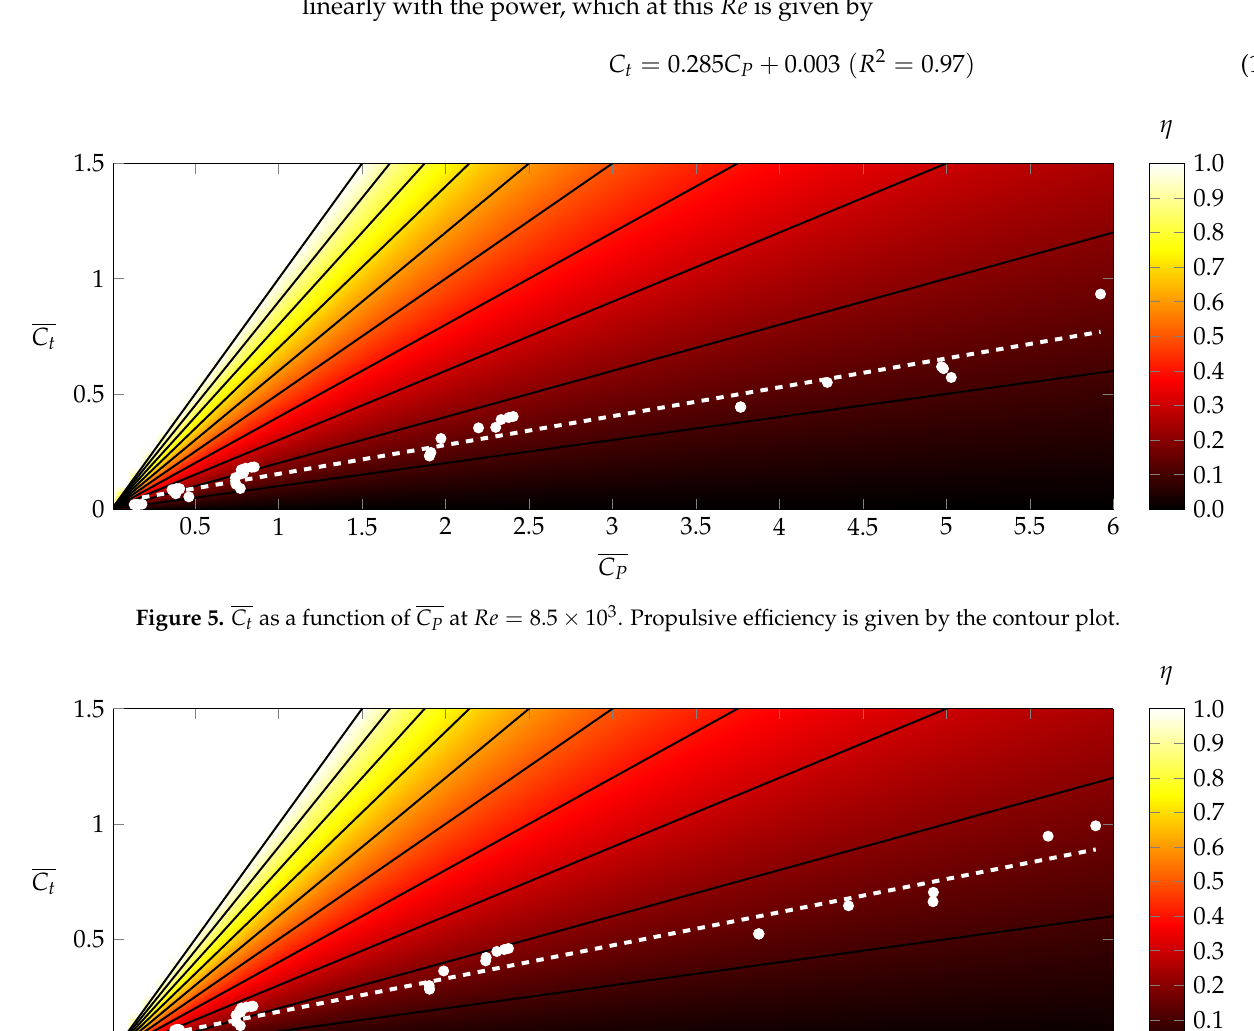
Figure 6. C t as a function of C P at Re = 1.7